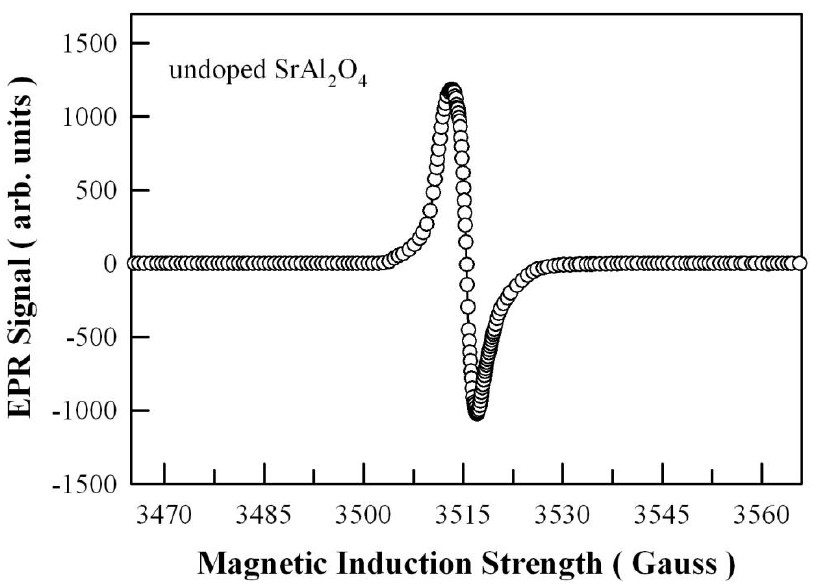
Figure 8. EPR spectrum of undoped SrAl 2 O 4 measured at room temperature. Microwave frequency: 9.856 GHz; microwave power: 20 mW.